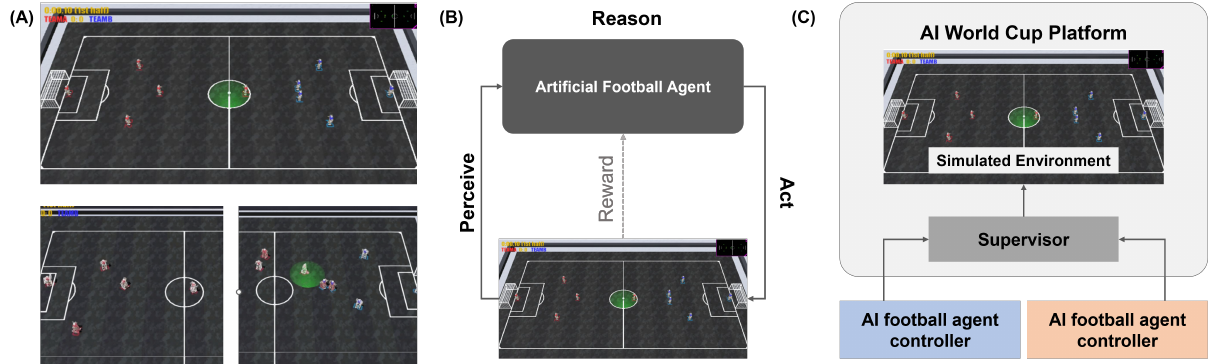
Figure 3. Environment: ( A ) AI World Cup environment (top) and its working examples (bottom). ( B ) An abstract framework of artificial football agents. ( C ) The layout of the AI World Cup